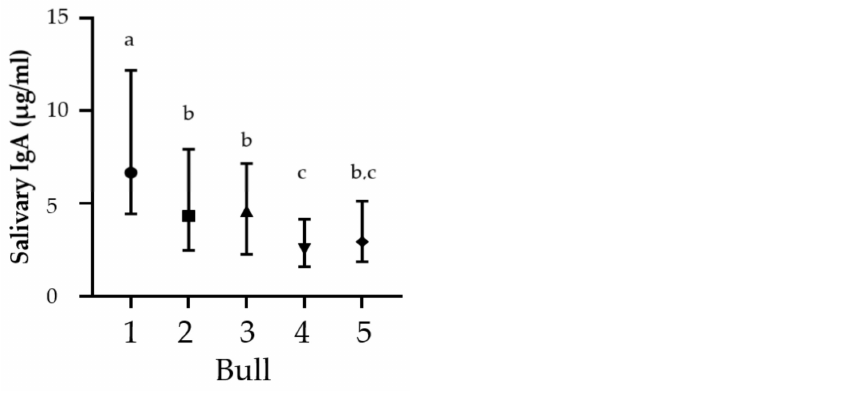
Figure 1. Median (and interquartile ranges) of secretory IgA concentrations for five bulls over the full study period. Superscript letters indicate significant differences Kruskal–Wallis test ( p < 0.05).